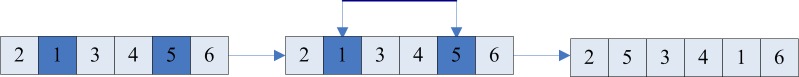
Mutation operation.